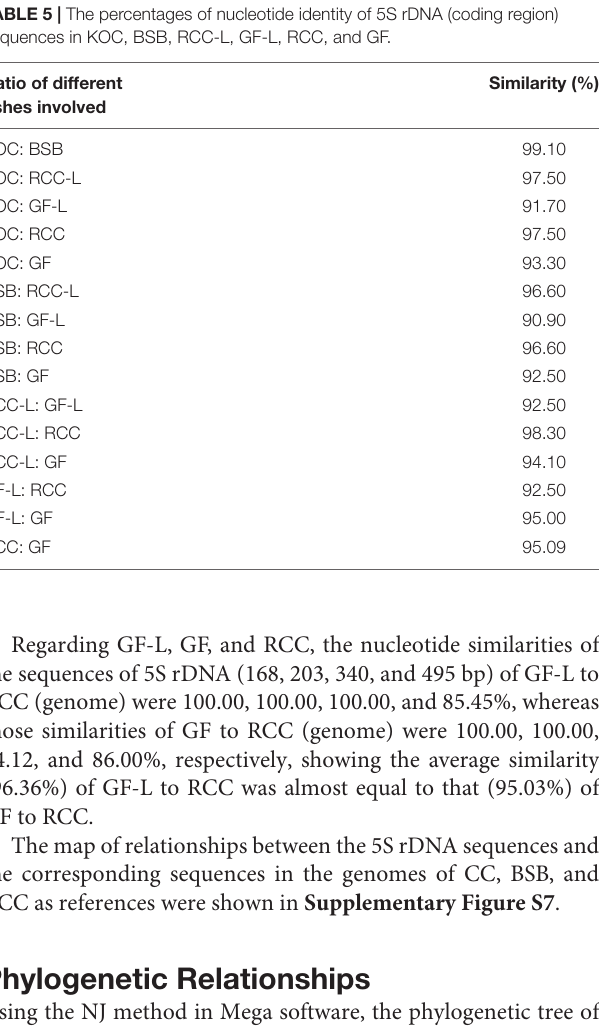
TABLE 5 | The percentages of nucleotide identity of 5S rDNA (coding region) sequences in KOC, BSB, RCC-L, GF-L, RCC, and GF. Ratio of different fishes involved